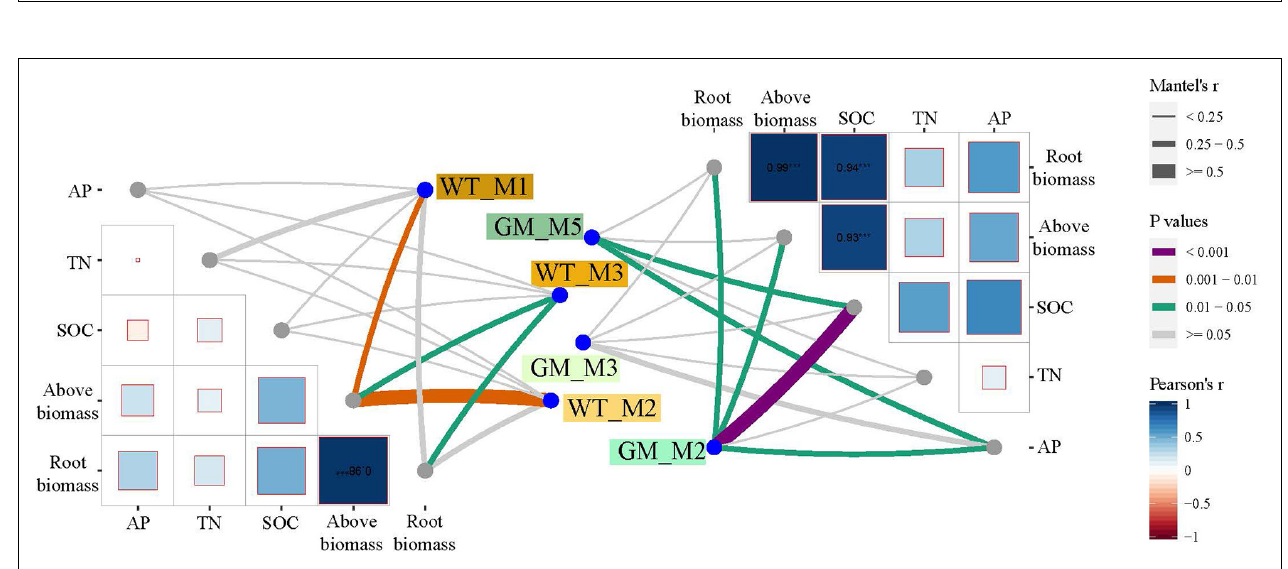
FIGURE 7 | Mantel test is the correlation analysis between modules obtained by network and edaphic physicochemical factors. The color of lines reflects the significance between data groups, and the thickness of lines reflects the correlation between data groups.